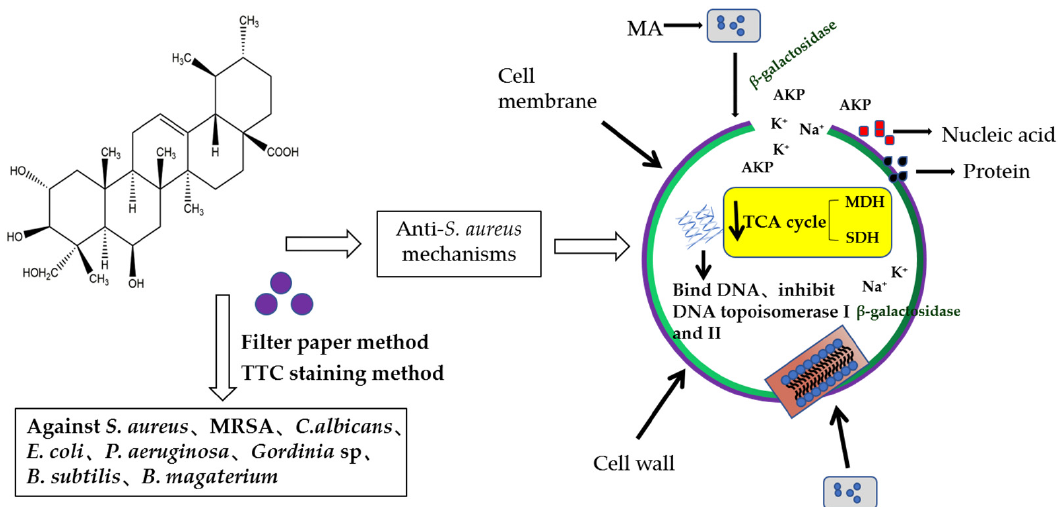
Figure 15. Antibacterial mode of MA aginst S. aureus .